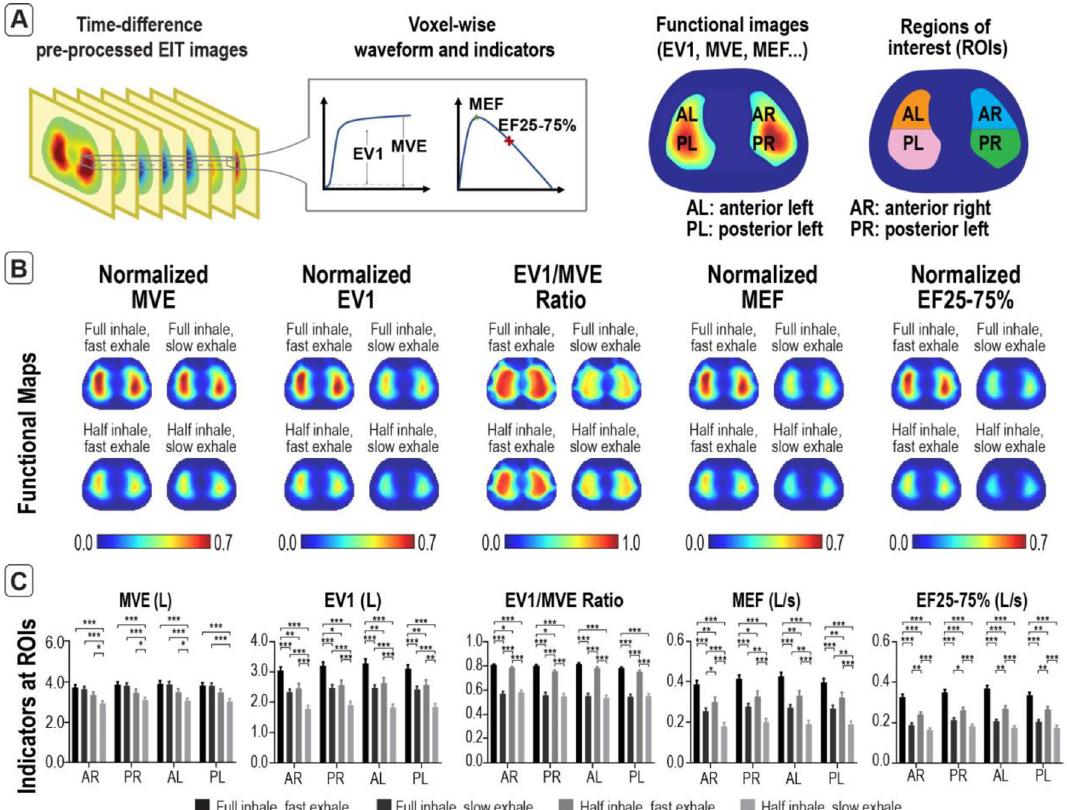
Figure 4. EIT-derived functional maps and regional EIT-derived indicators were consistent with the four corresponding breathing paradigms which is the combination of full or mid capacity inhale and fast or slow exhale. ( A ) Functional maps are obtained by evaluating the EIT indicators from the voxel-wise waveforms from which the regions of interest (ROIs) are inferred, including anterior left (AL), posterior left (PL), anterior right (AR) and posterior right (PR). ( B ) Averaged functional maps were calculated, allowing regional lung function assessment. ( C ) All regional indicators followed a similar trend, i.e., the MVE is higher in paradigms involving full capacity inhale, the EV1 is highest in full capacity inhale with fast exhale and is lowest in half capacity inhale with slow exhale, the EV1/MVE ratio is higher in paradigms involving fast exhale, the MEF is highest in full capacity inhale with fast exhale and is lowest in half capacity inhale with slow exhale, and the EF25-75% is highest in full capacity inhale with fast exhale and is lowest in slow exhale. * p < 0.05, ** p < 0.01, *** p < 0.001. Error bars indicate ± standard error of mean. Abbreviations: Maximal volume engaged (MVE), exhaled volume in 1 s (EV1), maximum expiratory flow (MEF), expiratory flow at 25–75% of maximum volume engaged (EF25-